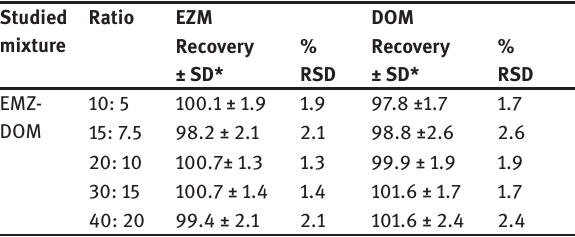
Table 5: Application of the proposed spectrodensitometric method for determination of the studied drugs in synthetic mixtures.